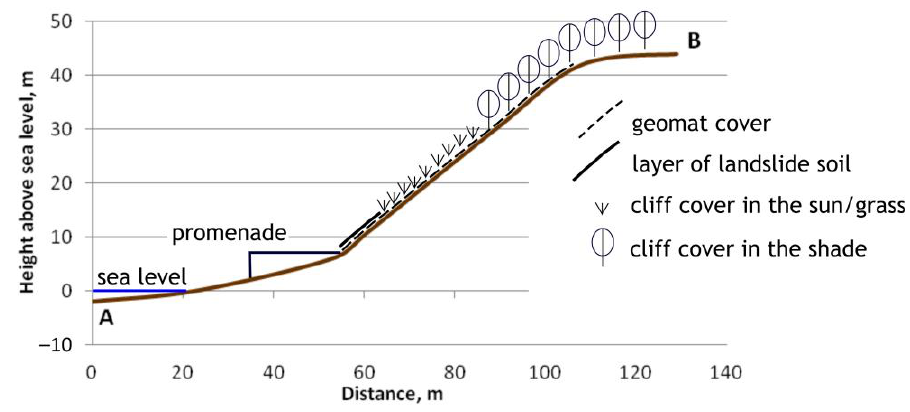
Figure 3. Cross profile of the slope drawn along the line AB (location see on Figure 5).